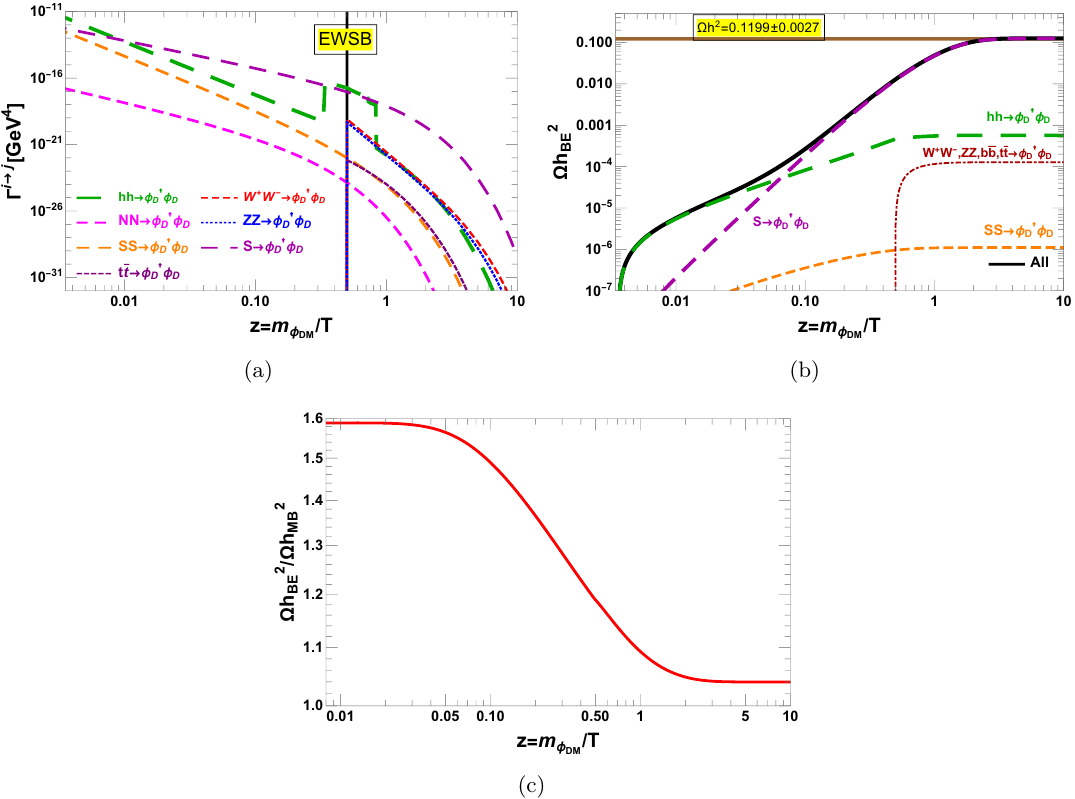
Figure 7 . The figures correspond to Scenario-3 . Figure 7(a) shows the relativistic reaction rates for different process corresponding to production of φ individual contributions to the relic density, and the total relic density. The brown horizontal line represents the present experimentally measured relic density [54]. Figure 7(c) shows the relative enhancement in the relic density with respect to Maxwell-Boltzmann